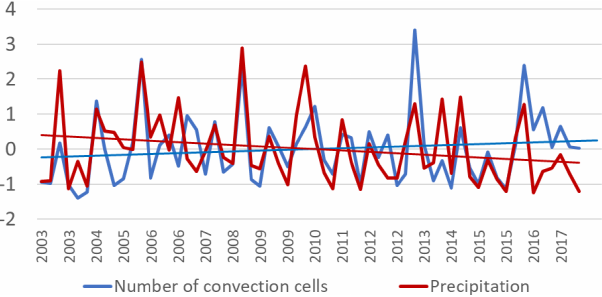
Figure 11. Basin-averaged standardized anomalies of the number of storm cells and precipitation amounts for the months of the active season (May to August) in the period 2003–2017. The precipita- tion amounts averaged over the Prut basin are computed from the gridded dataset with 10km resolution in latitude and longitude. The correlation coefficient is